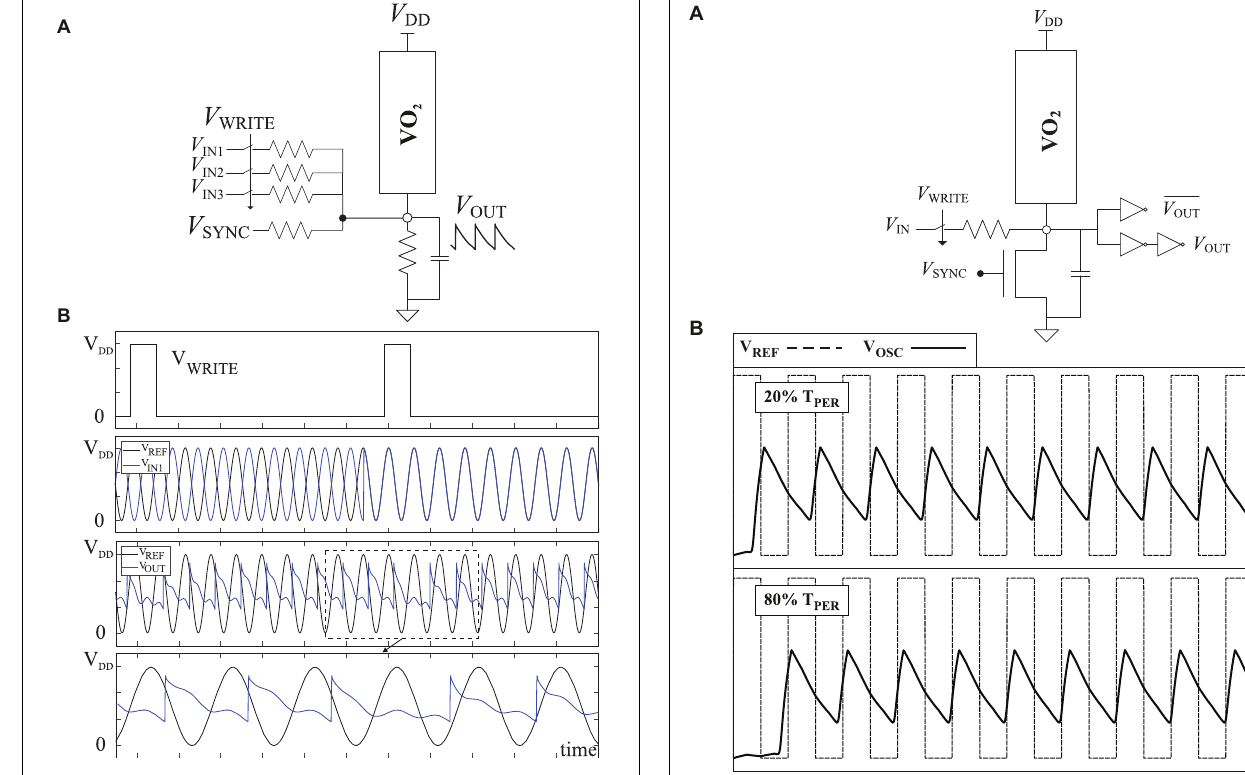
it is injected through the gate of the transistor avoiding the injection resistor. In the neuron, it contributes to reducing period variations due to device variability, which translates to frequency synchronization advantages in the ONN network. Figure 4B depicts its operation. The oscillator output before the static logic, V OSC , and a reference signal are shown. The use of SHIL reduces the number of phases to two. It can be observed that the oscillation phase can be controlled by the supply voltage delay like in the original ONN described in the background section. Supply voltages delays under half the oscillation period (top waveform in Figure 4B ) lead to one phase and delays over half period (bottom waveform) force the other